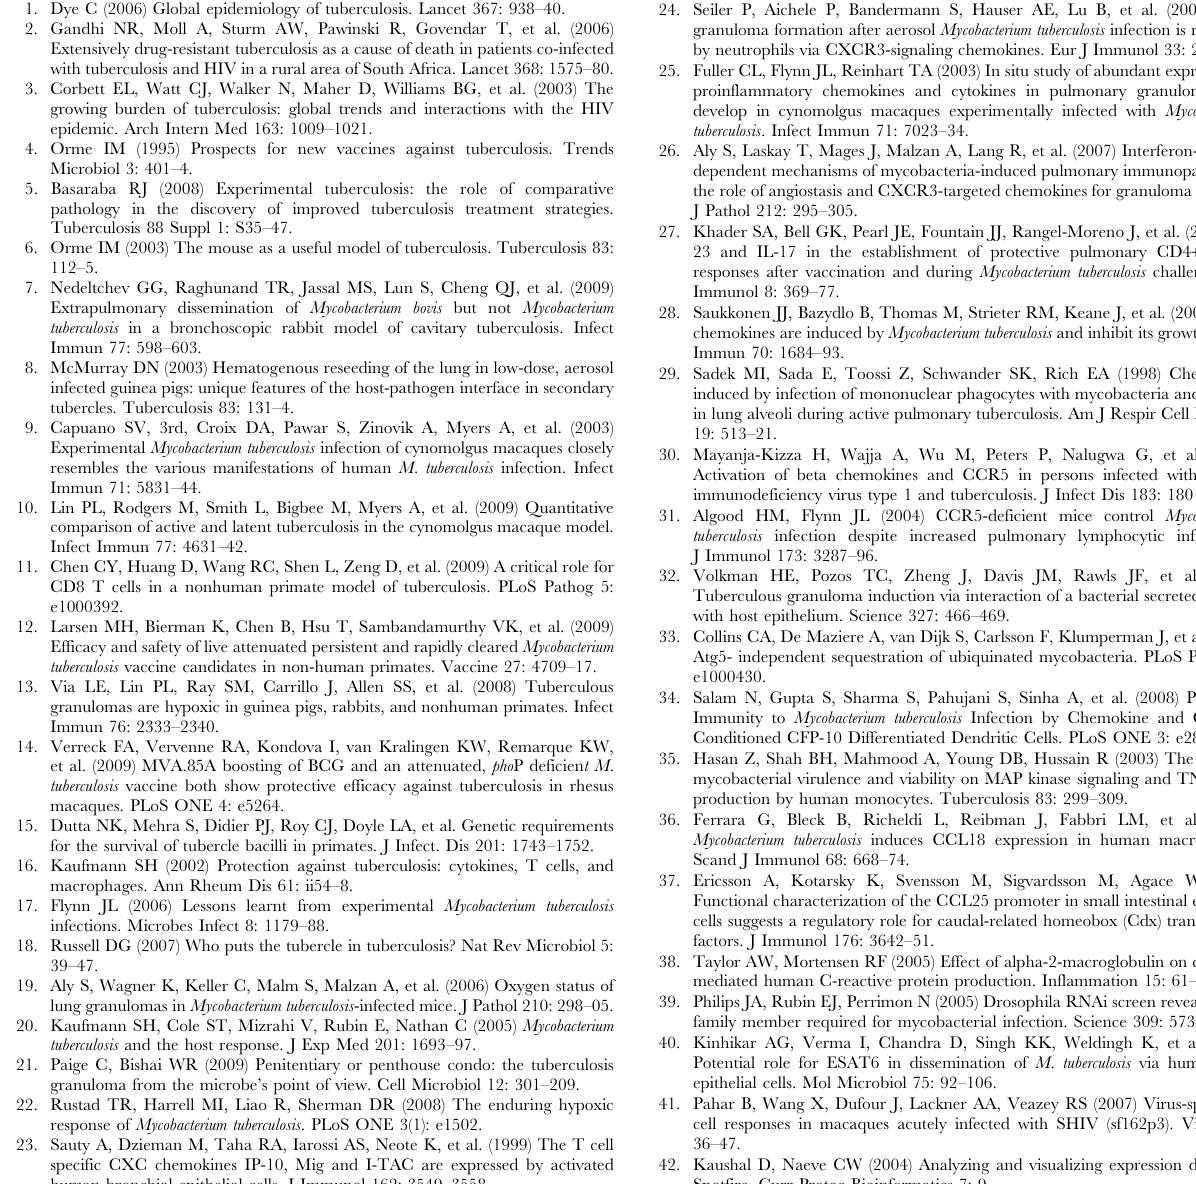
Pathway illustrations are shown for week 4 (A) and week 13 (B)